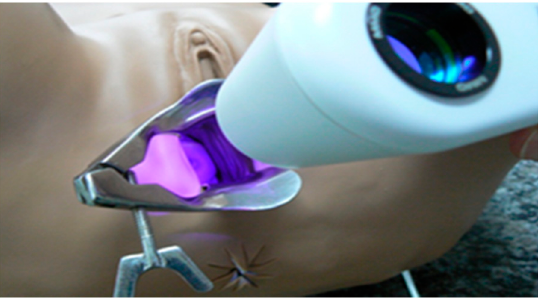
Figure 2. Representative image of the visualization of cervix fluorescence with the CerCa 150 System® using the laser probe emitting at 405 nm.